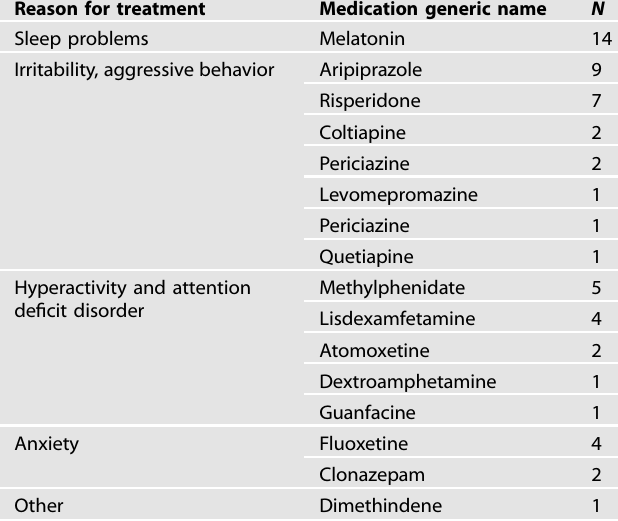
Table 1. Chronic medications taken by participants during the study. Table 2. Characteristics of participants who completed the study at treatment